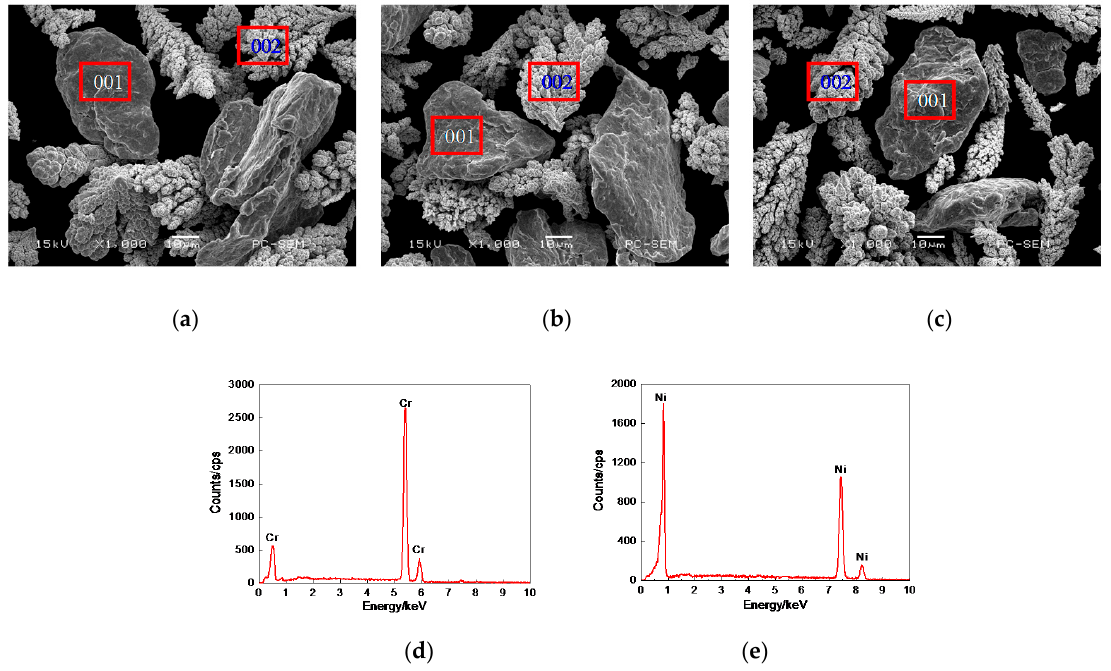
Figure 1. Morphologies and EDS analysis of Cr–Ni powders with different mass ratios of Cr and Ni. ( a ) Morphology of 17% Cr–83% Ni powder; ( b ) Morphology of 20% Cr–80% Ni powder; ( c ) Morphology of 24% Cr–76% Ni powder; ( d ) EDS analysis at 001 point; ( e ) EDS analysis at 002point.